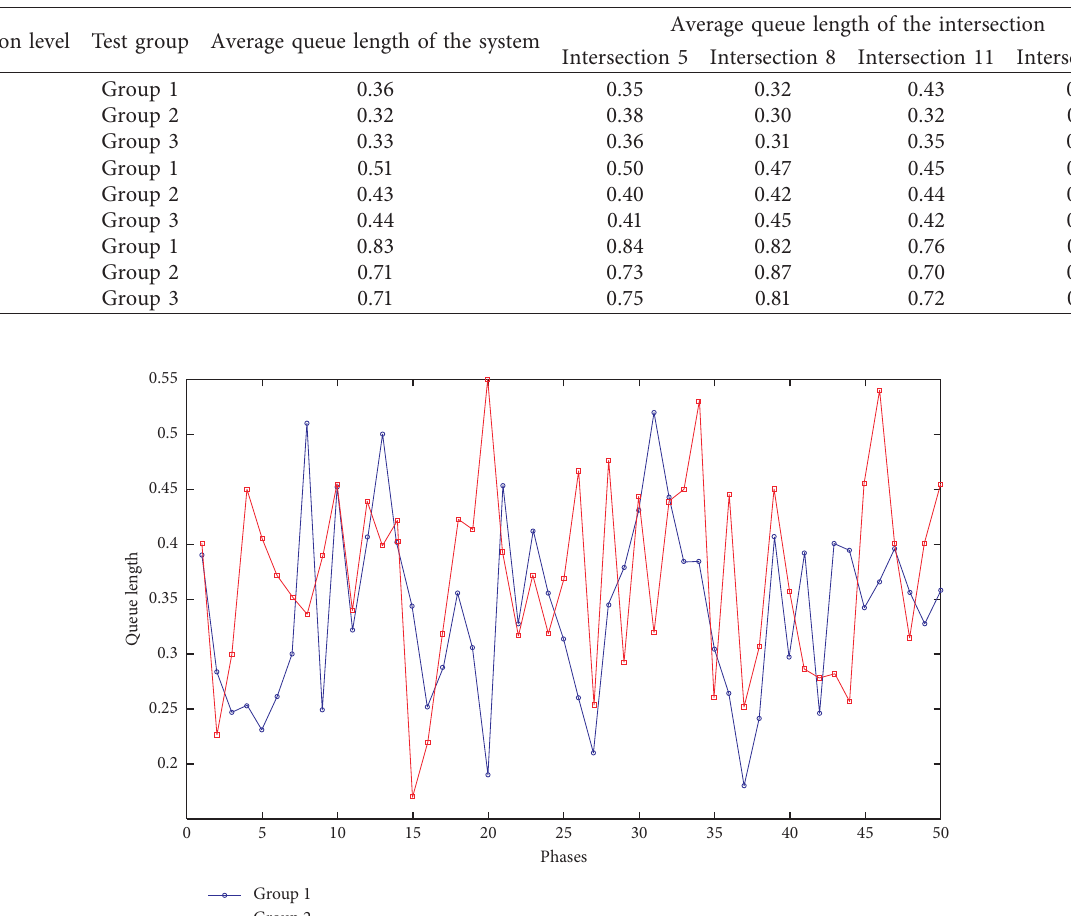
Table 4: Queue length-based improvement analysis of optimization methods.